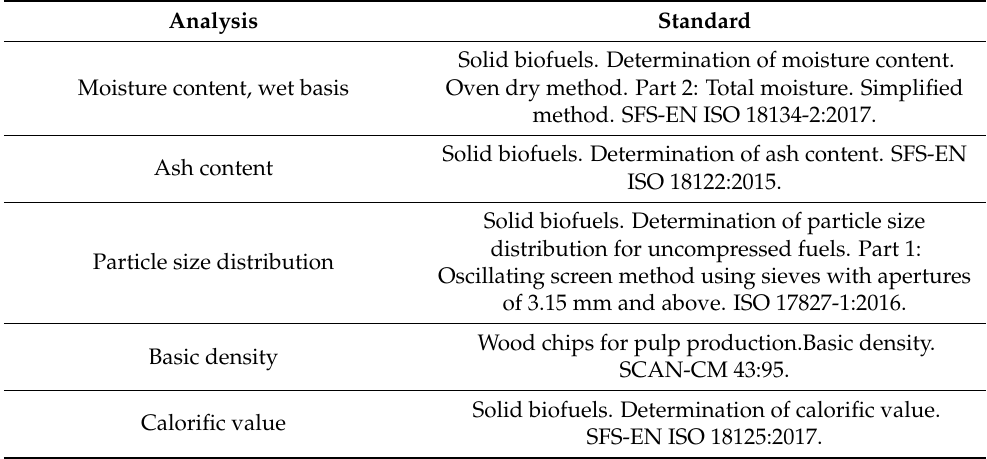
Table 1. Standards applied to determine pre- and post-storing chip properties.